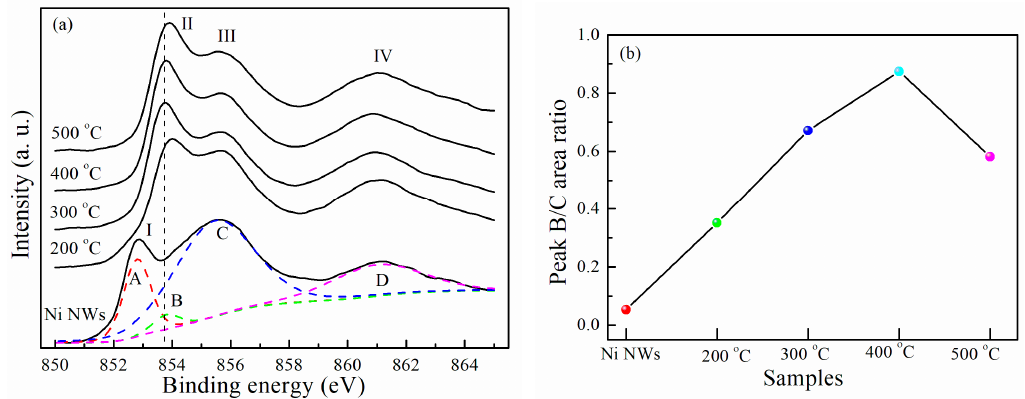
Figure 3. Ni 2p 3/2 XPS spectra ( a ) and peak B/C area ratio ( b ) as a function of oxidation temperature.